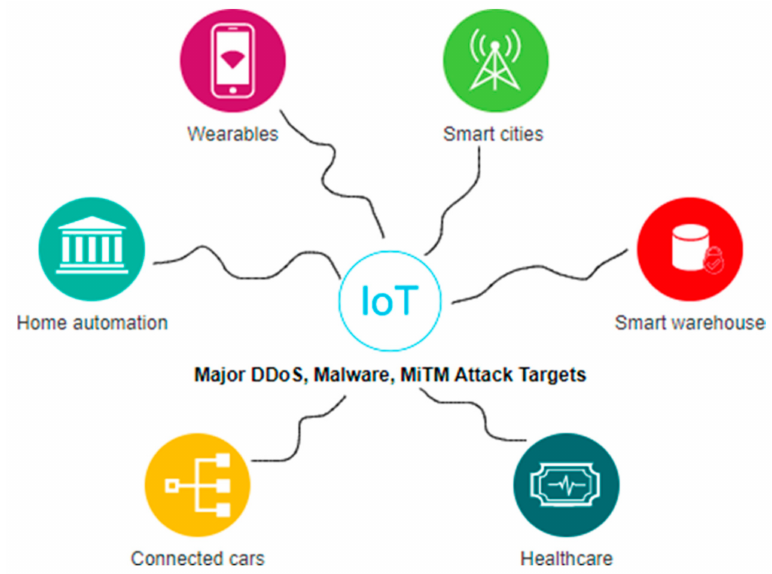
Figure 2. Major IoT Attack